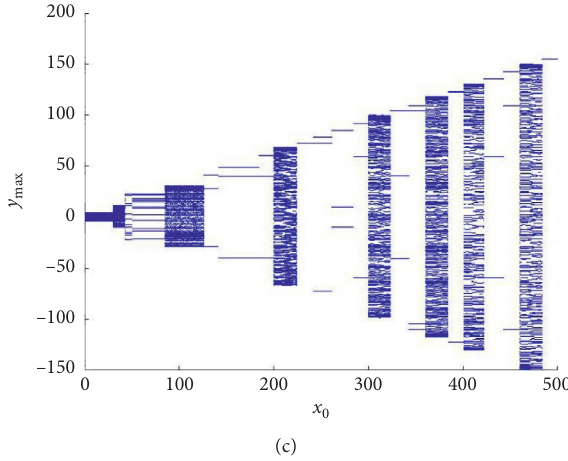
Figure 4: Lyapunov exponents and bifurcation diagrams for A � 1 and w � 0 . 8 when the initial conditions are set ( x largest Lyapunov exponents are demonstrated. Therefore, the third, which is the most negative, is not shown. (b) x time-series local maximums. (c) y time-series local maximums.